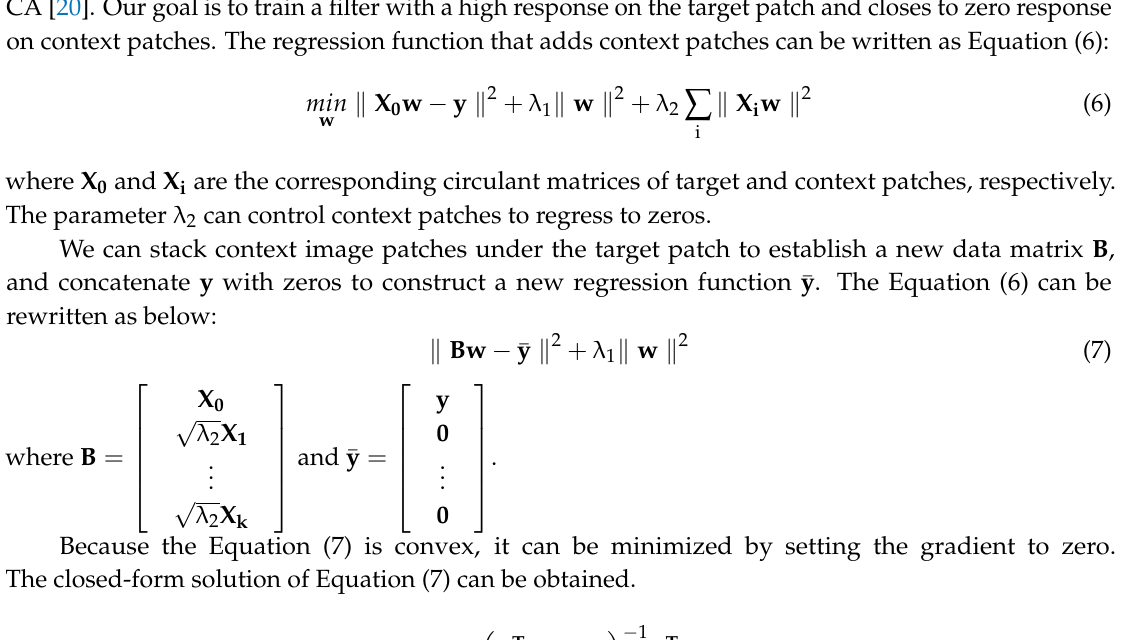
Figure 3. Sampling procedure of proposed strategy .